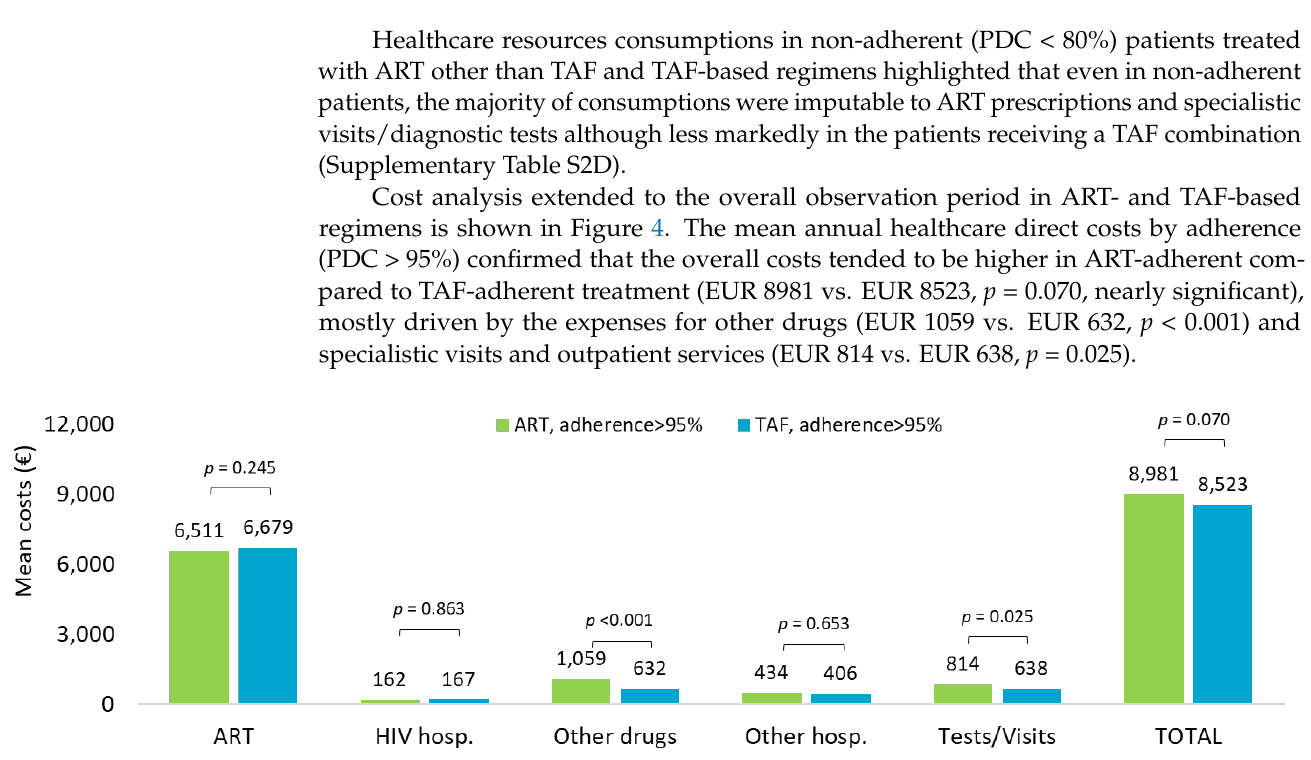
Figure 3. Mean annual health care costs (EUR) during first year of follow-up for patients with TAF-based regimen based on adherence.